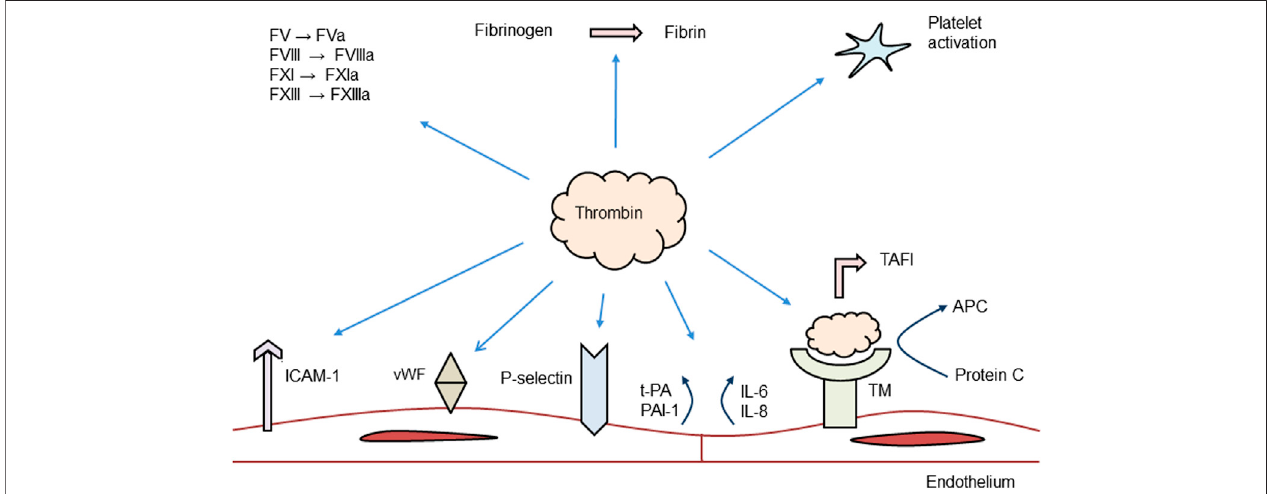
FIGURE2| Roleofthrombininthecoagulationsystem.ICAM,intracellularcelladhesionmolecule;PAI,plasminogenactivatorinhibitor;vWF,vonWillebrandfactor; IL,interleukin;TAFI,thrombin fi brinolysisactivatableinhibitor;TM,thrombomodulin;APC,activatedproteinC;andF,coagulationfactor.Modi fi edfrom(Davidson,2013).